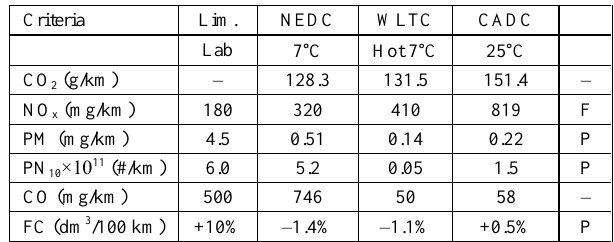
Table 7. Emissions as reported by ERDeIDE for the cycles prescribed in the prize rules. F = Fail, P = Pass. Lim. =